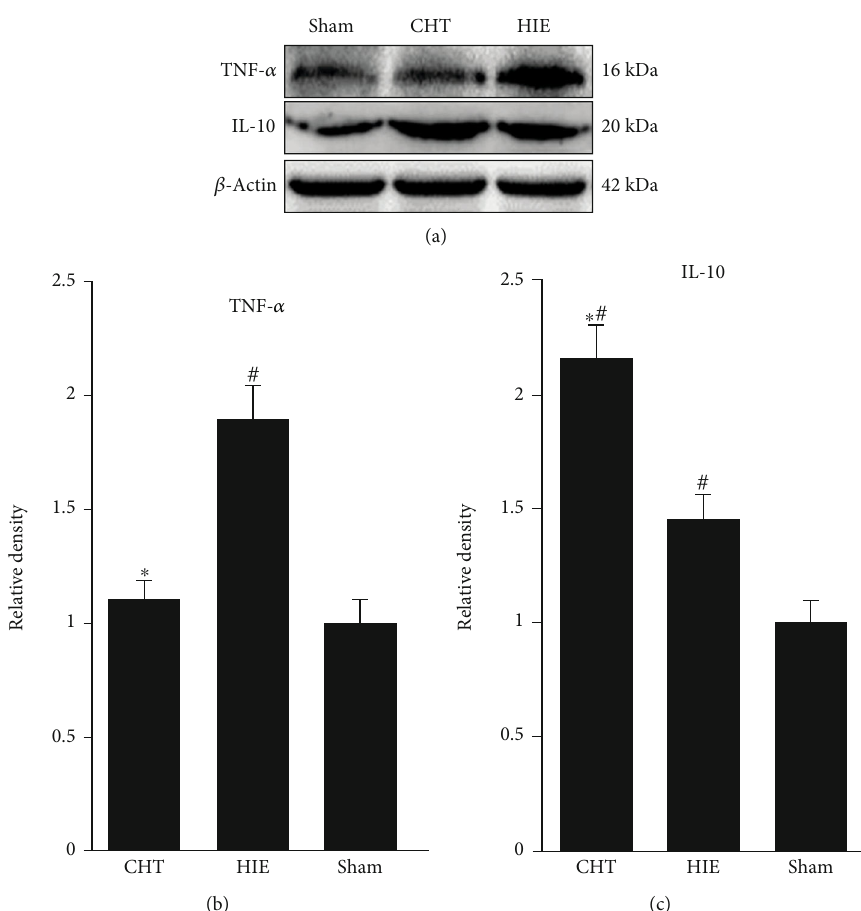
Figure 3: Chinese Tuina improved the neuroin fl ammatory reaction in rats with HIE. (a) Representative images of Western blotting for TNF- α and IL-10. (b, c) Quanti fi cation of the optical density for TNF- α and IL-10, normalized to β -actin. ∗ P < 0 : 05 , comparison with the HIE group; # P < 0 : 05 , comparison with the sham group, n = 5